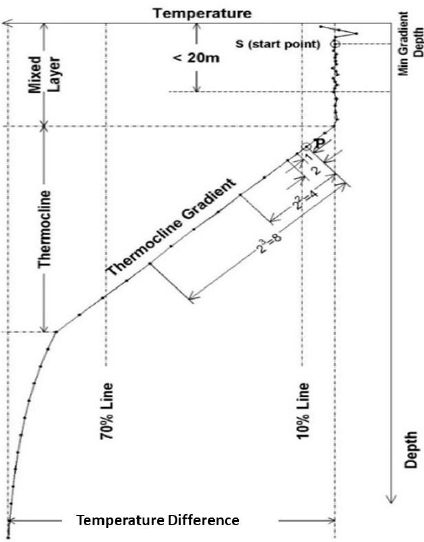
Figure 1. Determination of isothermal layer (ITL) depth ( h ) from an individual temperature profile. The 10% (70%) line represents the 10% (70%) temperature difference between the isothermal layer and deep layer.